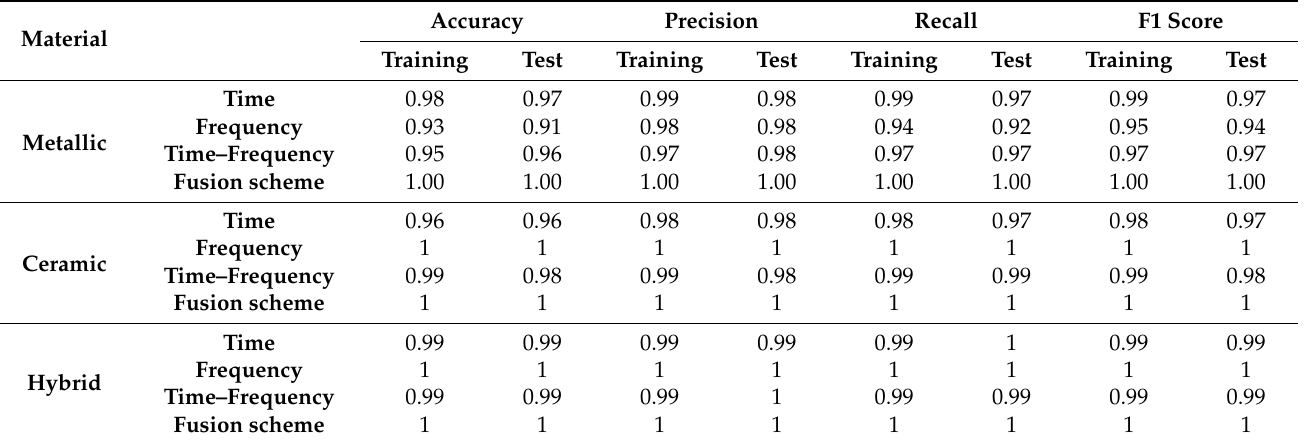
Table 8. Performance metrics of the proposed method based on SAE and SoftMax layer for the particular evaluation of each feature domain and the proposed fusion